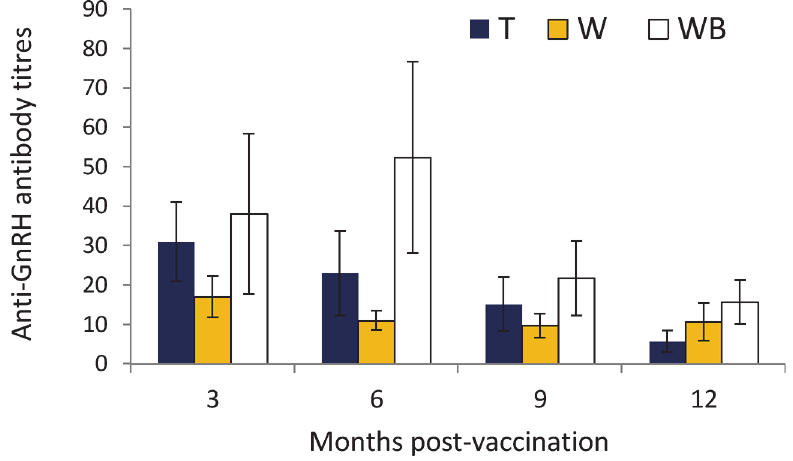
Fig 3. Mean (SD) anti-GnRH antibody titres for cattle treated with the immunocontraceptive vaccine GonaCon. All cattle received a single dose of GonaCon, WB received a booster dose three months later.